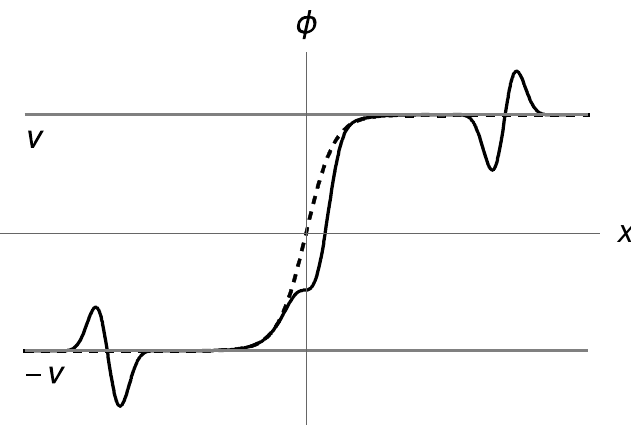
Figure 1 . The soliton together with the wave package before, while and after passing through the soliton (solid line), compared with the unperturbed soliton (dotted